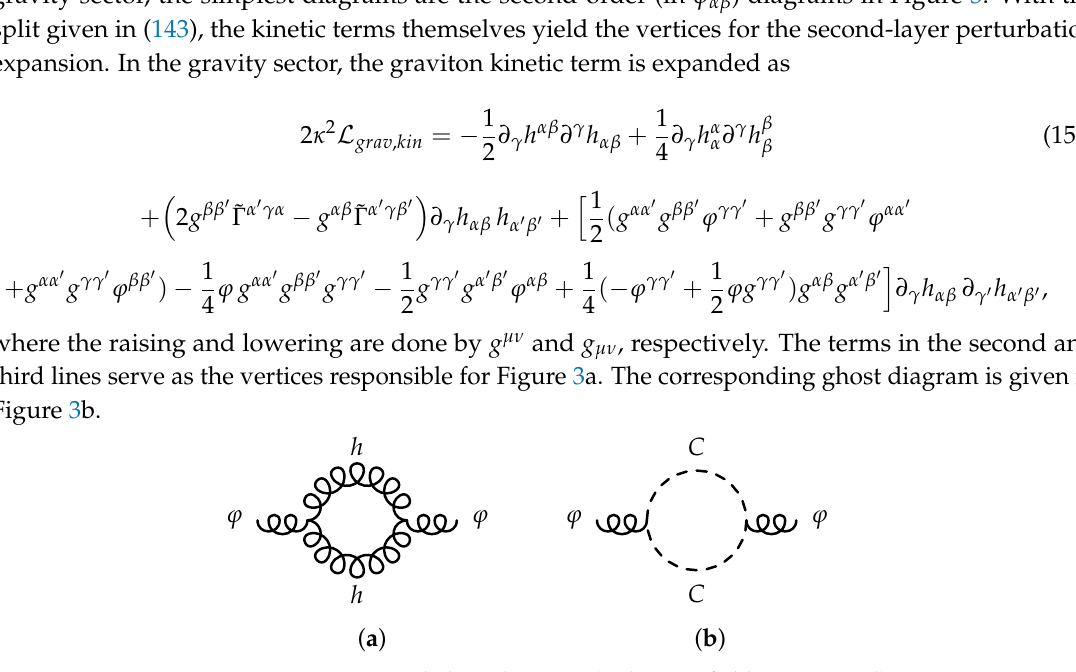
Figure 3. Graviton and ghost diagrams (indices on fields suppressed).